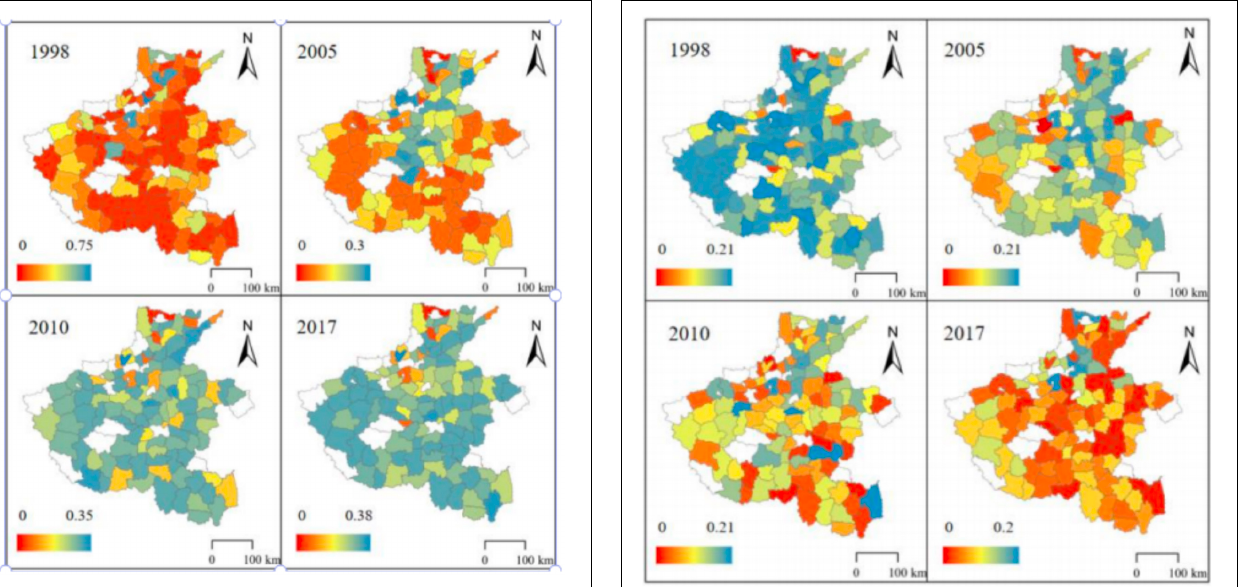
FIGURE 7 | Spatial difference of job security function of cultivated land in Henan Province.